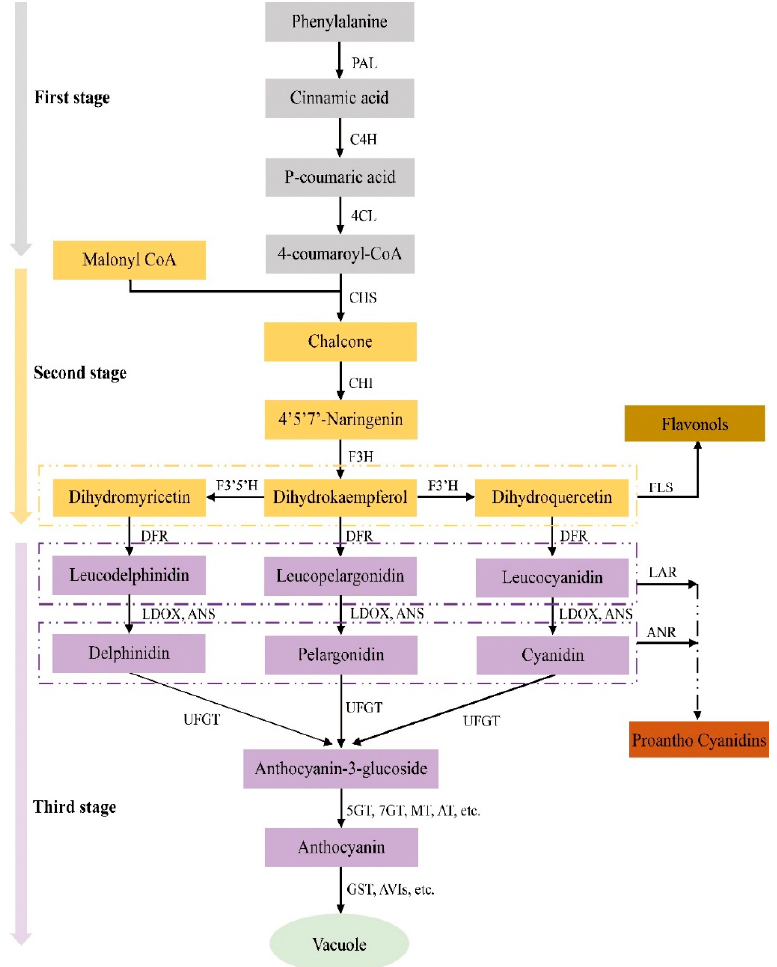
Figure 4. Biosynthesis pathway of anthocyanins in plants. PAL, Phenylalanine ammonia lyase; C4H, Cinnamate 4-hydroxylase; 4CL, 4-coumarate CoA ligase; CHS, Chalcone synthase; CHI, Chalcone isomerase; F3H, Flavanone 3-hydroxylase; F3 ′ H, Flavonoid 3 ′ -hydroxylase; F3 ′ 5 ′ H, Flavonoid 3 ′ ,5 ′ -hydroxylase; DFR, Dihydroflavonol 4-reductase; ANS, Anthocyanidin synthase; LDOX, leucoanthocyanidin dioxygenase; UFGT, Flavonoid 3-O-glucosyltransferase; 5GT, Anthocyanin 5-O-glucosyltransferase; 7GT, Flavonoid 7-O-glucosyltransferase; MT, Methyl transferase; AT, Anthocyanin acyltransferase; GST, Glutathione S-transferase; AVIs, Anthocyanic vacuolar inclusions.